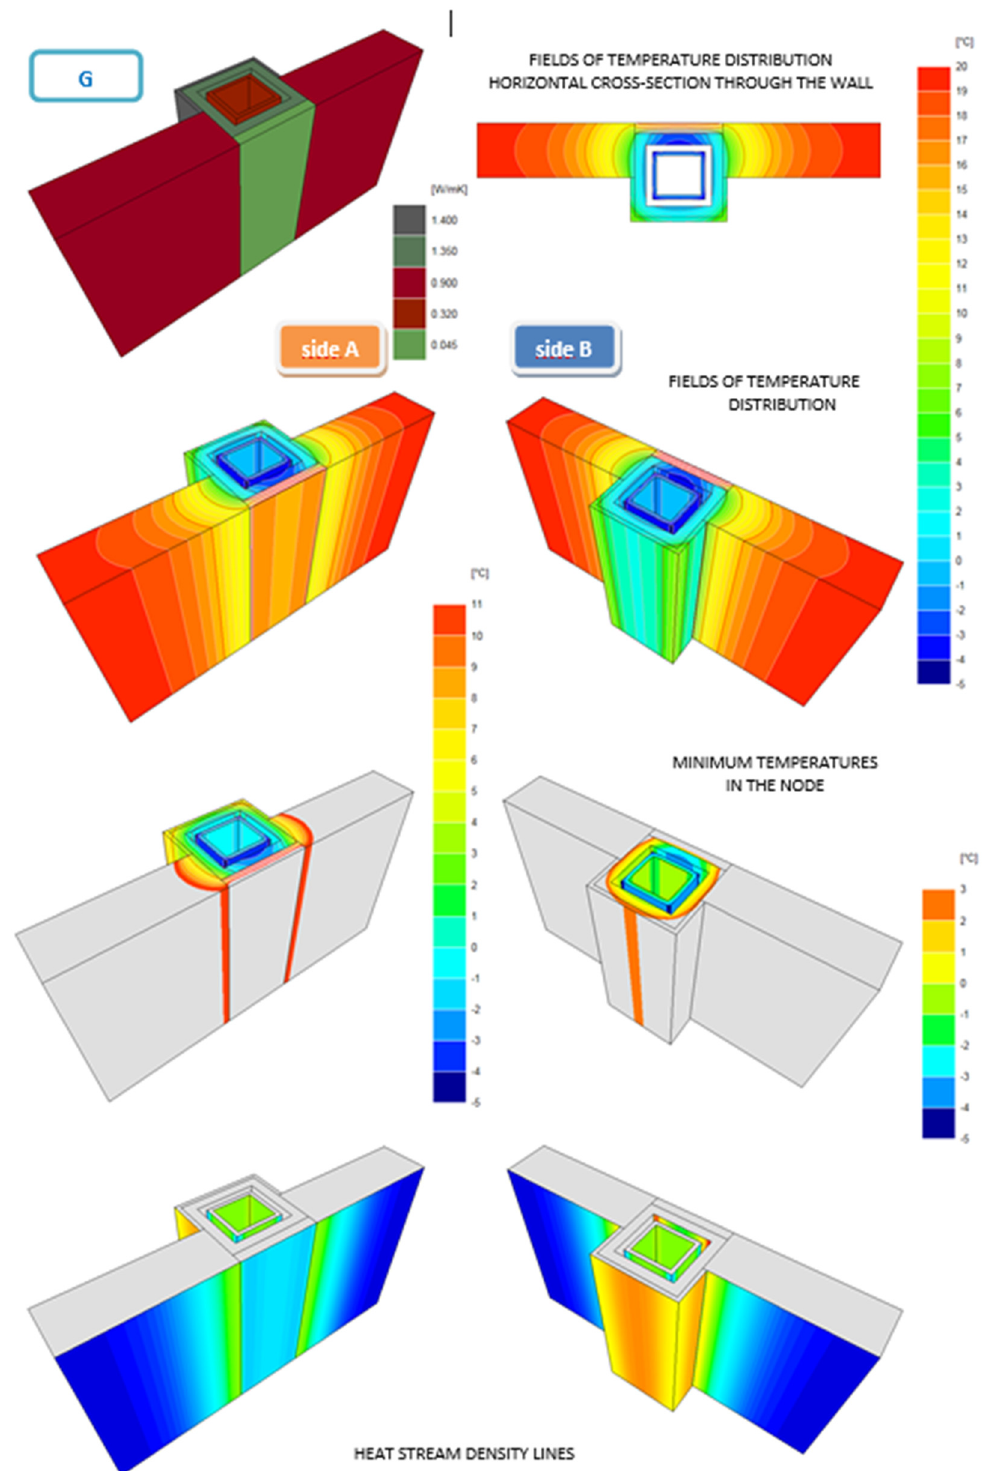
Figure A8. Scheme G: distribution of isothermal field, minimum surface temperature, and heat flux distribution.